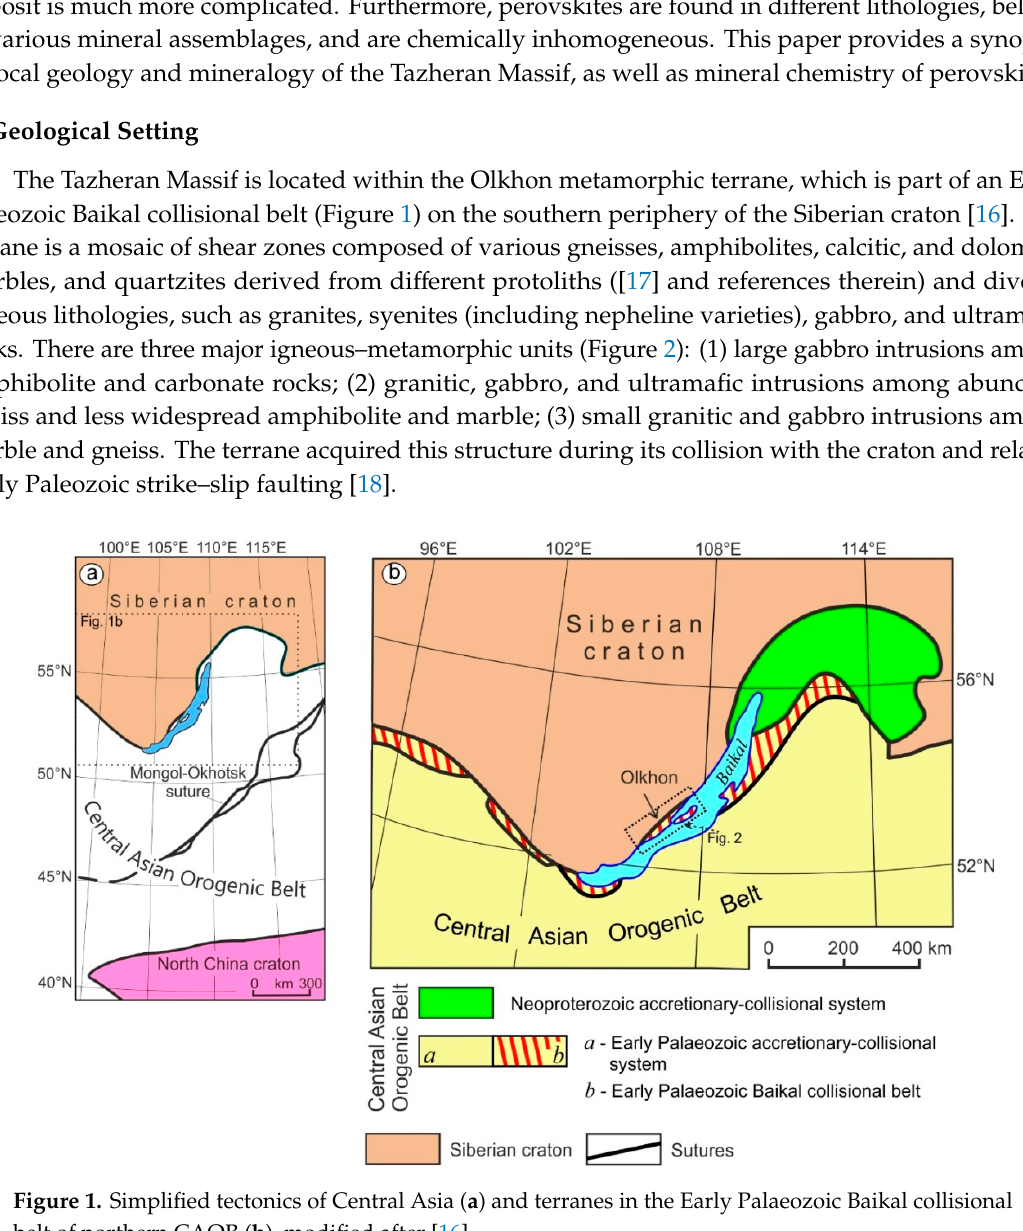
Figure 2. Simplified tectonics of the Olkhon terrane, modified after [16]: Tazheran Massif is shown as a black circle. Calcic metasomatic rocks are located among calcite marble around the Tazheran complex and follow linear amphibolite bodies (altered mafic dikes?). In some cases, they form thin zones within